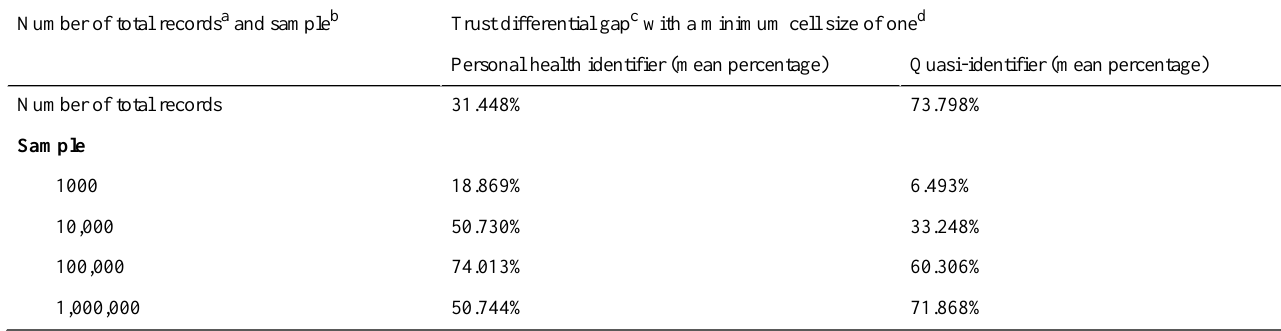
Table 2. The averaged trust differential gap according to total records and random samples.